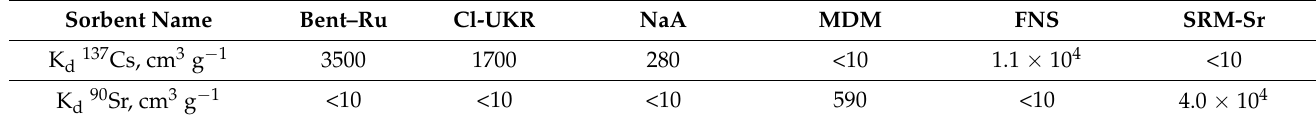
Table 4. The distribution coefficient (K d ) values of 137 Cs and 90 Sr during sorption from seawater on various